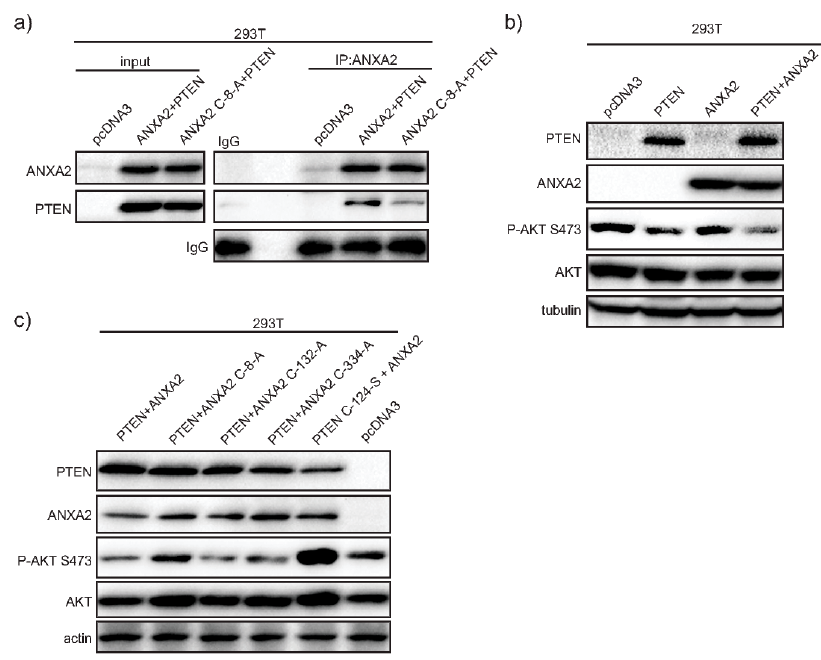
Figure 2. ANXA2 via its Cys-8 REDOX sensitive residue binds to PTEN and regulates its activity. ( a ) 293T cells transfected with either empty vector; ANXA2 and PTEN-GFP expression plasmids or ANXA2 Cys-8-Ala and PTEN-GFP expression plasmids were grown in 60 mm plates. Cells were washed with PBS, lysed with Triton X-100 lysis buffer degassed for 1 h on ice. 300 µg of each cell lysate was incubated with the indicated antibodies for 1 h at 4 °C and then 50 µL of pre-washed 50% slurry protein G-Sepharose™ (GE Healthcare) was added for 1 h at 4 °C. Beads were washed four times with 300 µL of lysis buffer, resuspended with 20 µL 2× SDS-PAGE loading buffer, boiled for 10 min, subjected to SDS-PAGE and analyzed by western blotting; 293T cells over-expressing ( b ) (1) empty vector, (2) PTEN, (3) ANXA2 or (4) ANXA2 and PTEN; or ( c ) (1) ANXA2 and PTEN, (2) ANXA2 Cys-8-Ala and PTEN, (3) ANXA2 Cys-132-Ala and PTEN, (4) ANXA2 Cys-334-Ala and PTEN, (5) ANXA2 and PTEN Cys-124-Ser or (6) pcDNA3 (empty vector) were grown in 60 mm plates in DMEM complete medium for 24 h. Cell lysates were prepared and 20 µg of each protein extract was subjected to SDS-PAGE, transferred onto nitrocellulose membranes and analyzed by western blotting with the antibodies indicated.